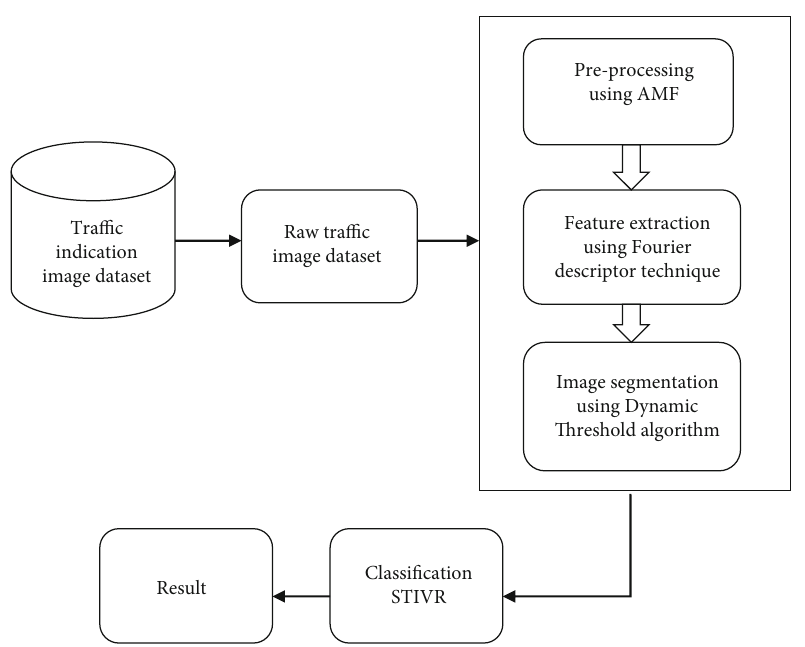
Figure 2: The proposed diagram of the tra ffi c